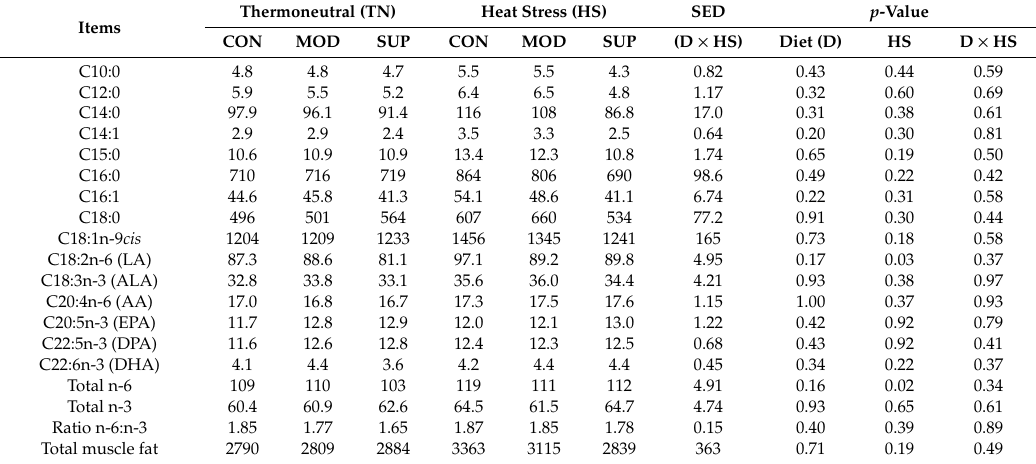
Table 2. Muscle (longissimus lumborum) fatty acid composition (mg / 100 g muscle) of lambs finished on 4 weeks of experimental diets followed by one week of thermal